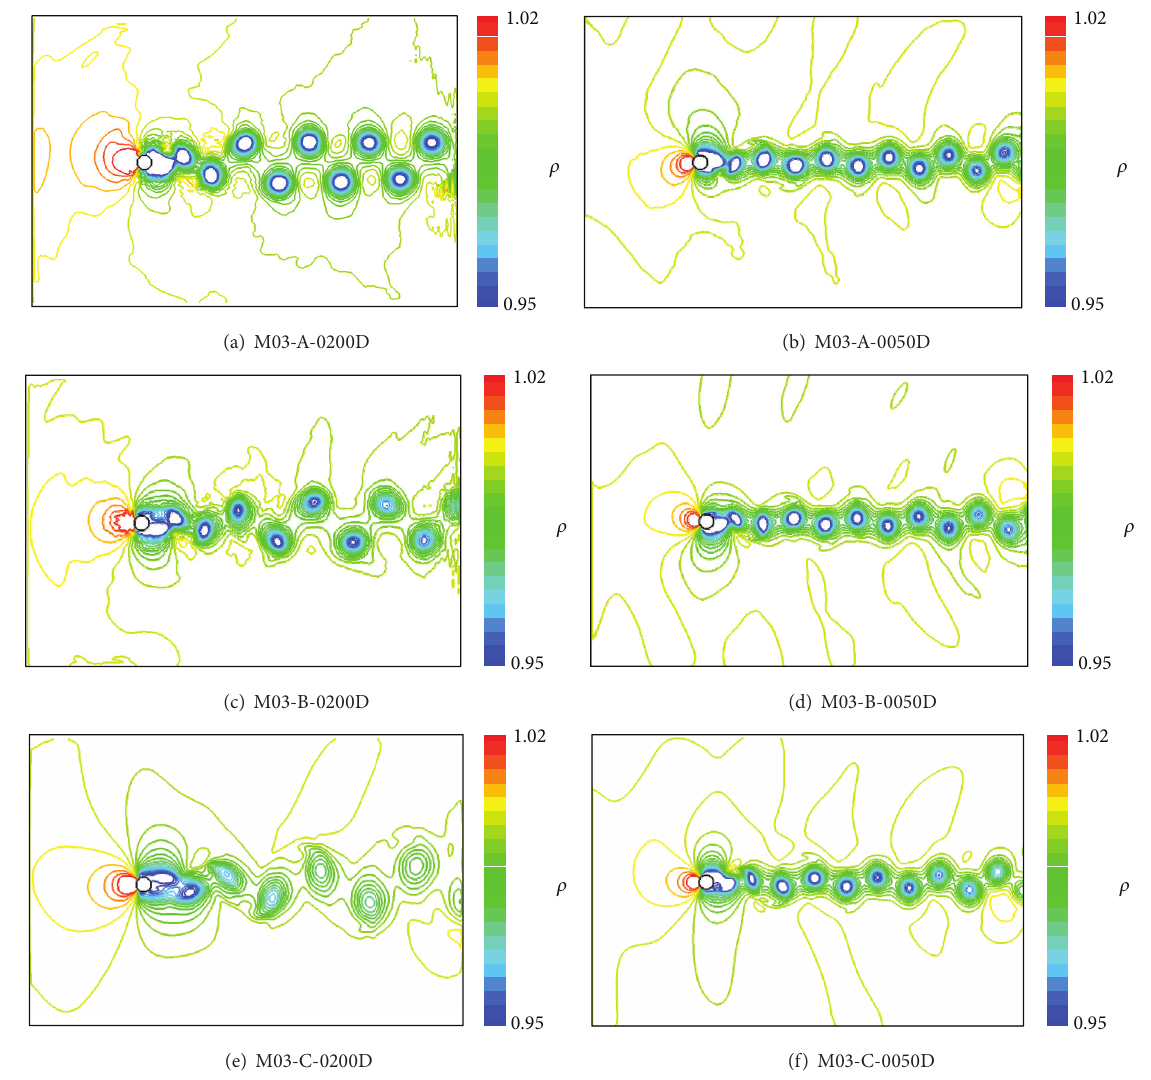
Figure 8: Density contours in Mach